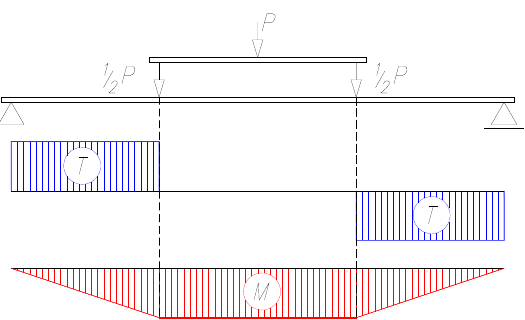
Figure 6. Distribution of bending moments (M) and shear forces in the assumed static scheme.